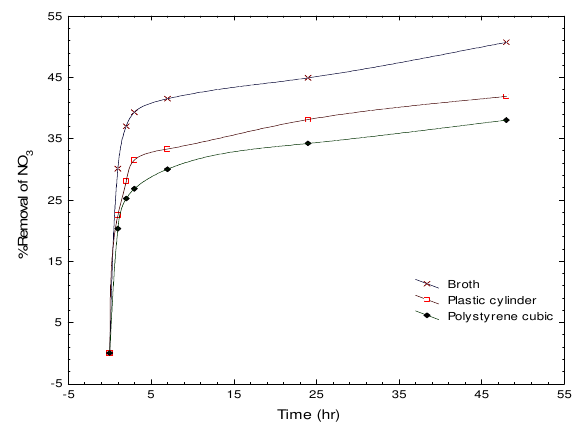
Fig. 16. Effect of Packing type on the concentration level of COD pollutant with time at T=25 o C, pH 7, and sterilized wastewater.